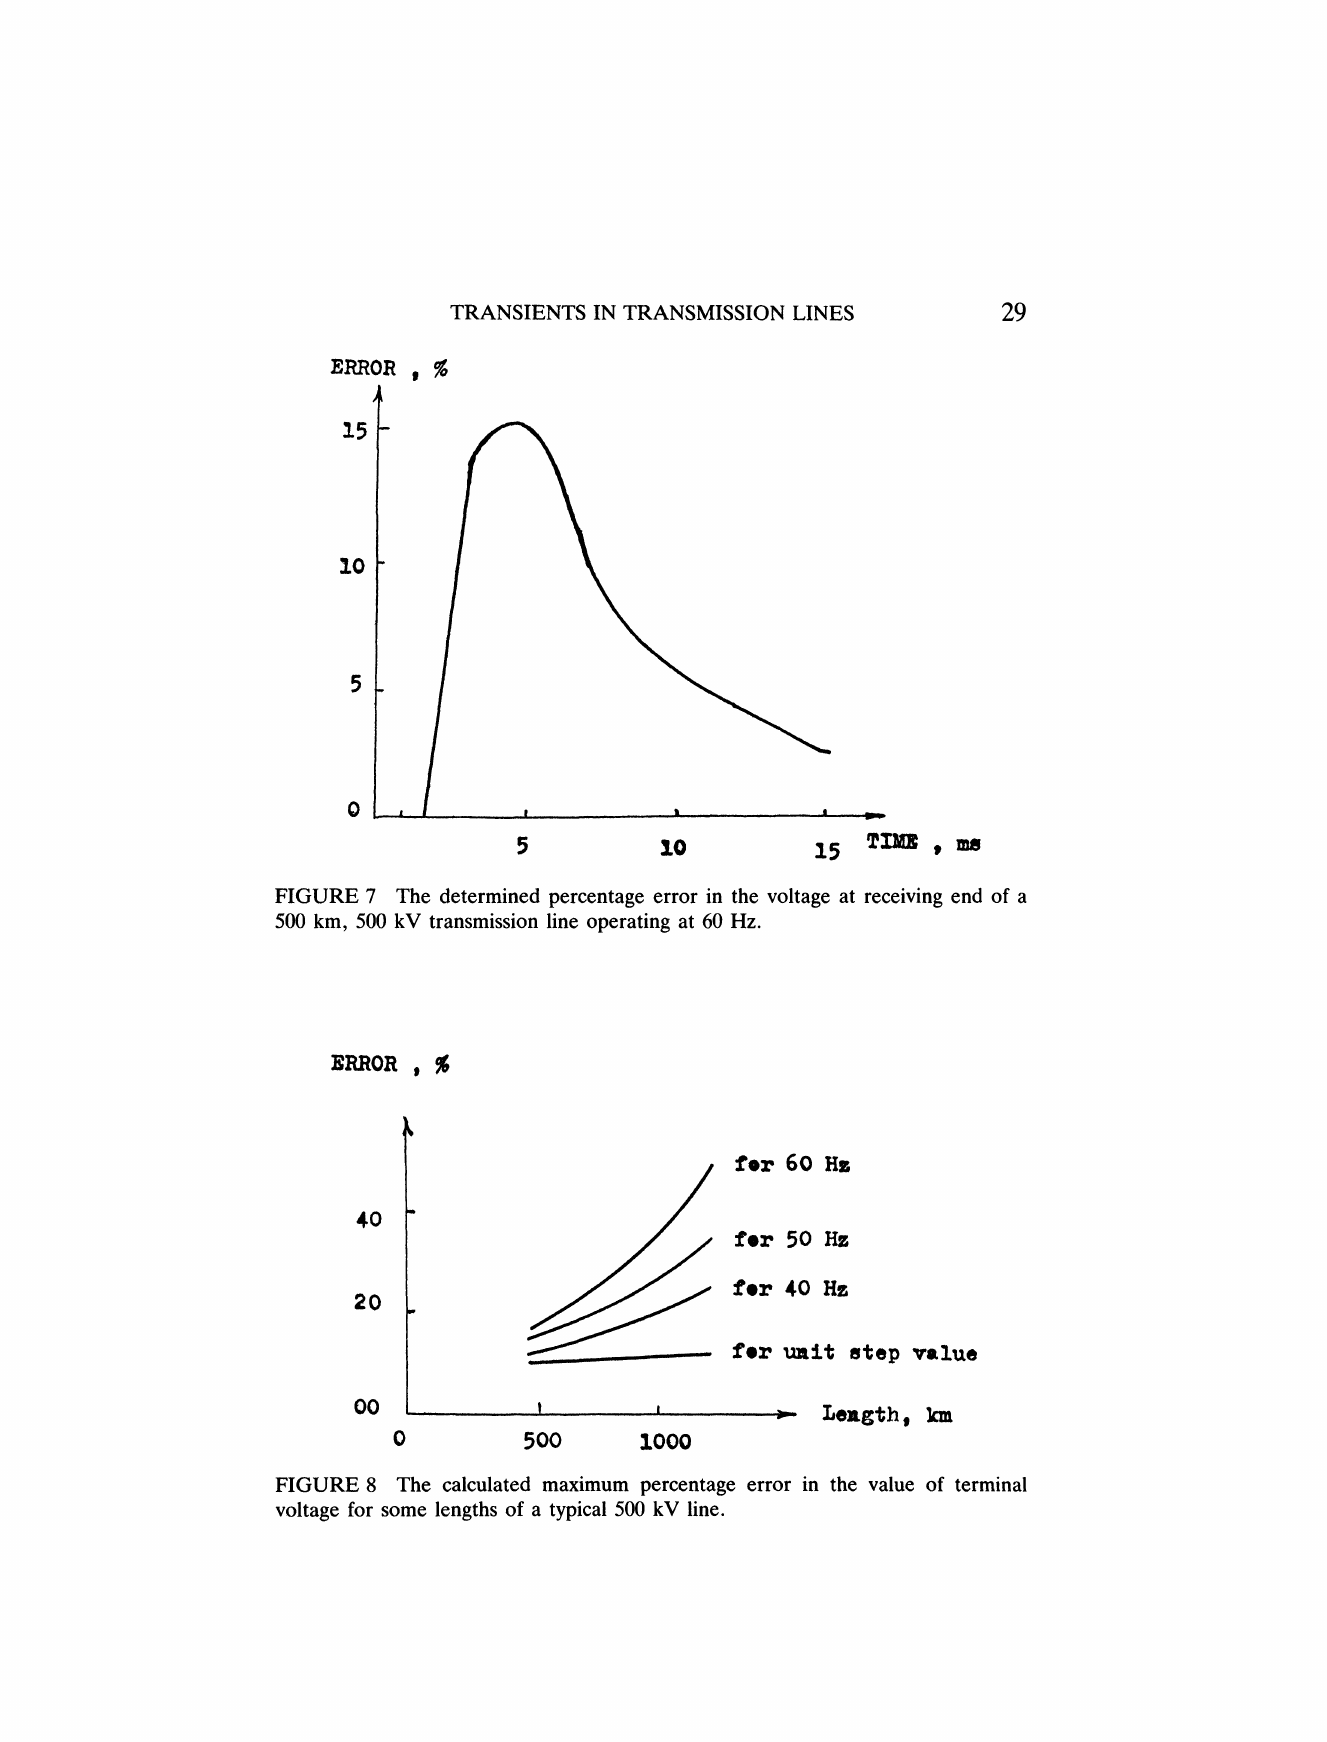
FIGURE 8 The calculated maximum percentage error in the value of terminal voltage for some lengths of a typical 500 kV